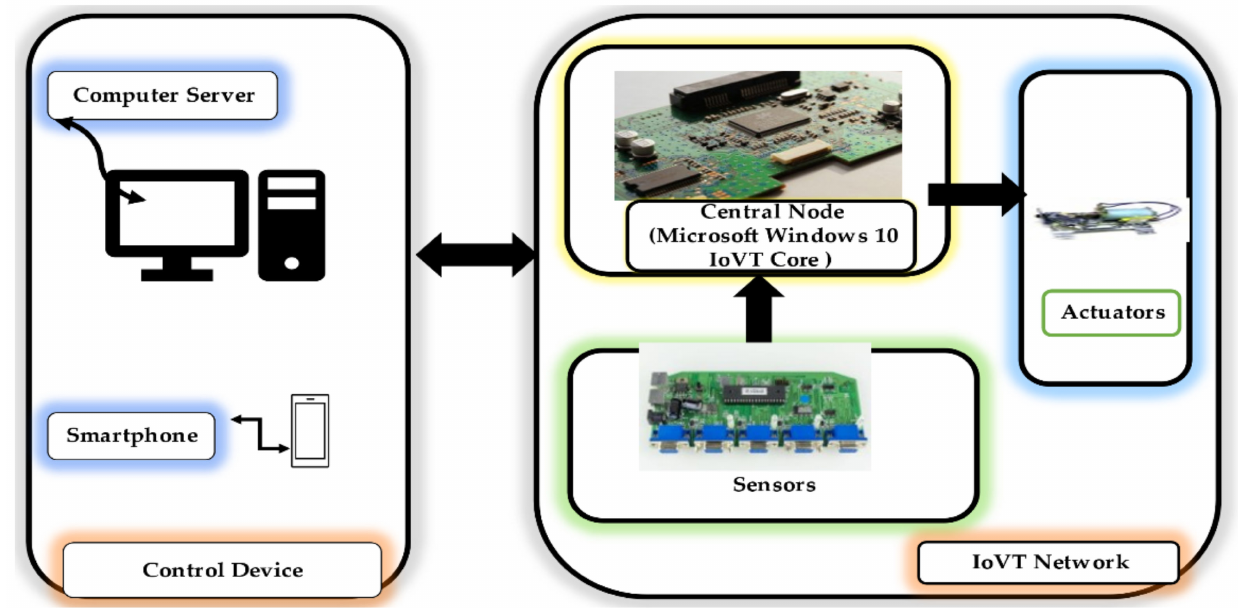
Figure 2. Topology for which the methodology is